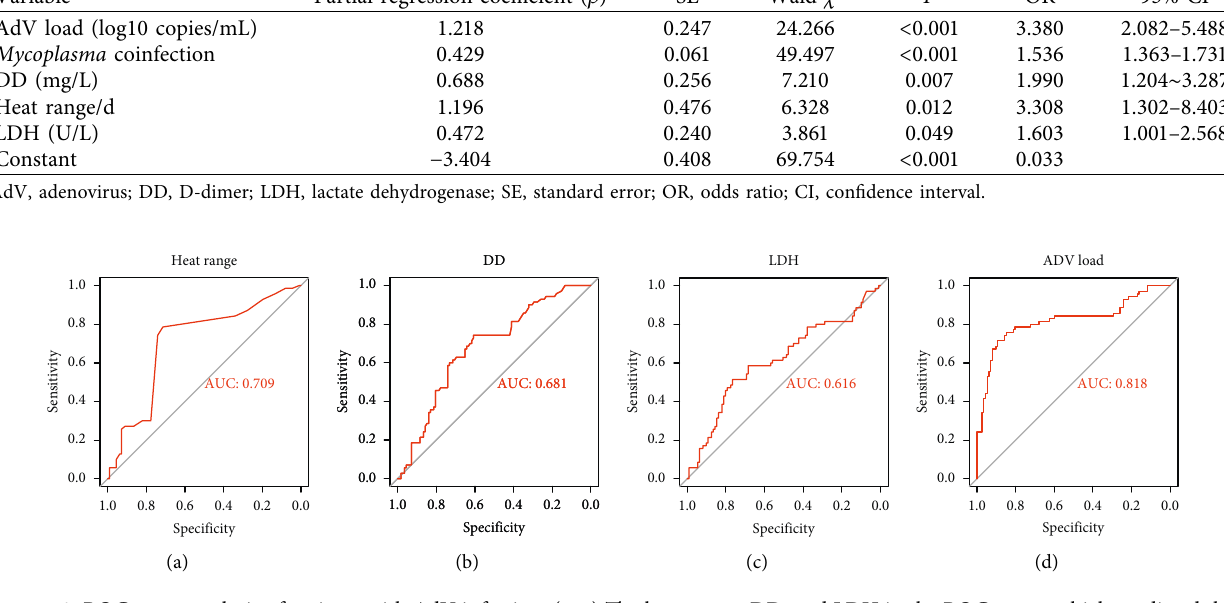
Figure 2: ROC curve analysis of patients with AdV infection. (a–c) The heat range, DD, and LDH in the ROC curve, which predicted the sensitivity and specificity of AdV pneumonia-BMP formation at 78.6% and 71.4%, 74.3% and 60.7%, and 51.4% and 76.8%, respectively. (d) The AdV load in the ROC curve, which predicted the sensitivity and specificity of AdV pneumonia--BMP formation at 71.4% and 89.3%, respectively. Table 4: Logistic regression analysis of patients with a single AdV